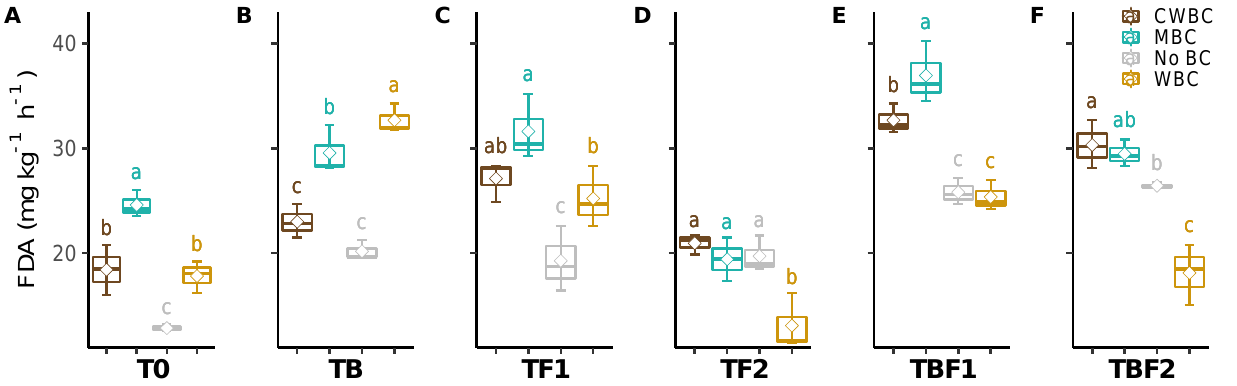
Figure 2. Effect of microbial inoculants on soil FDA hydrolytic activity after biochar application. Treatment abbreviations—see Figure 1. Quantiles are shown at the top and bottom of the box. Max and min values are indicated by the bars. The lines within the box indicate the median values. The transparent dot indicates the observation value. Letters above the bars indicate the significance level at p < 0.05 by LSD.